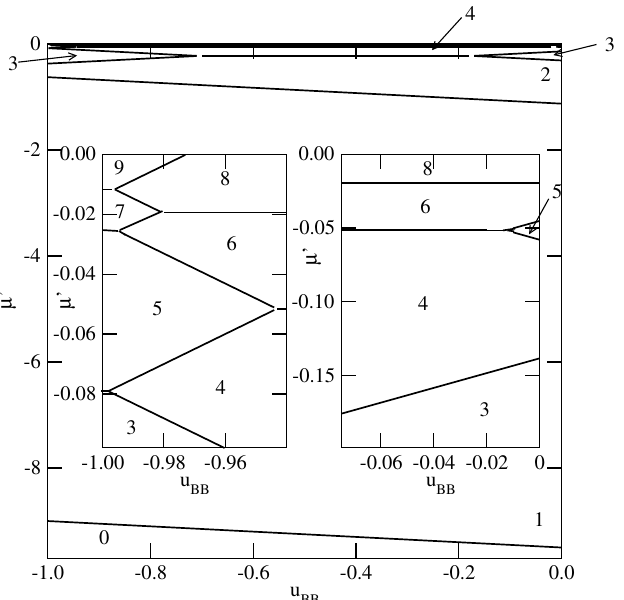
Figure 8. The ground state phase diagram for the system with V A = − 5.0 and V B = − 10.0. The right and left insets show the parts of the phase diagram corresponding to u BB close to 0 and to − 1.0, respectively. The numbers mark the numbers of layers stable in different